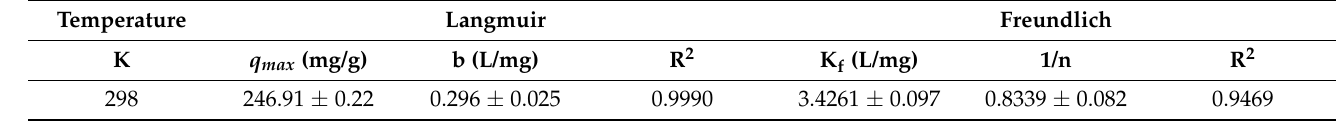
Table 2. Parameters of the isotherm model for the adsorption of Zn 2+ onto MnO 2 @PSS/PDDA/PSS.